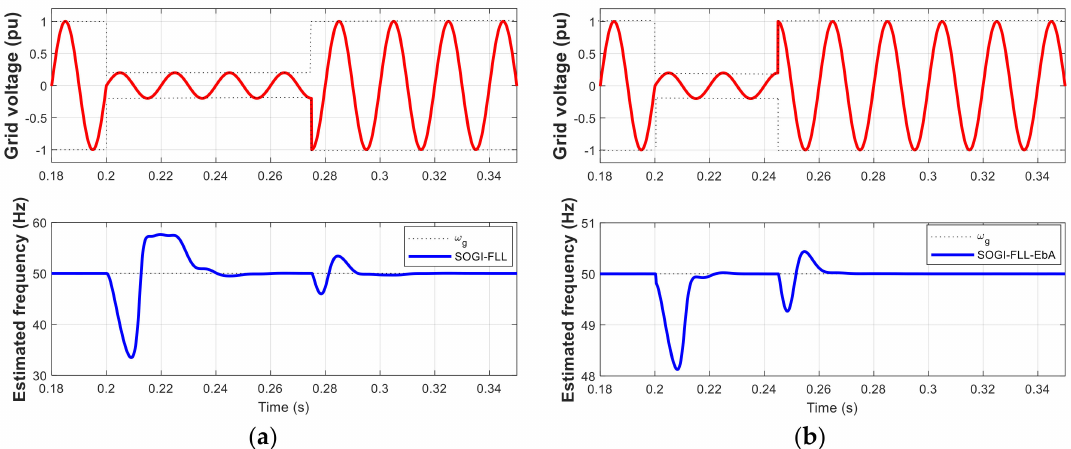
Figure 10. Transient response of the SOGI-FLL and SOGI-FLL-EbA to short-duration voltage sags. ( a ) SOGI-FLL response to a 0.2 pu voltage sag at 0.2 s with three cycles and three quarters of duration. ( b ) SOGI-FLL-EbA response to 0.2 pu voltage sag at 0.2 s with two and half cycles of duration.